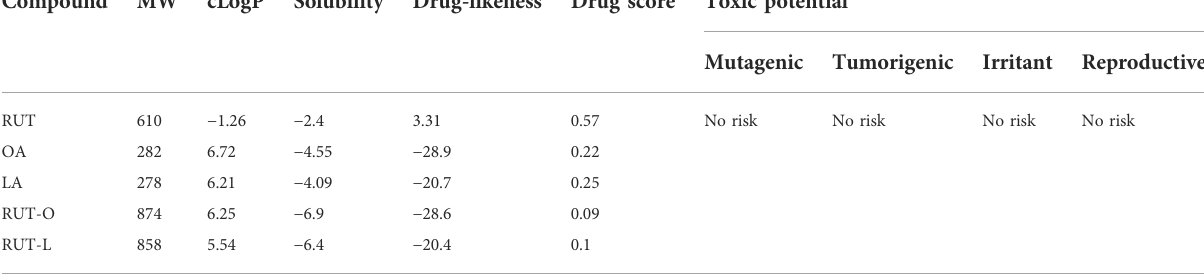
TABLE 2 Computational prediction of the properties exerted by RUT, OA, LA, RUT-O, and RUT-L by applying OSIRIS Property Explorer.